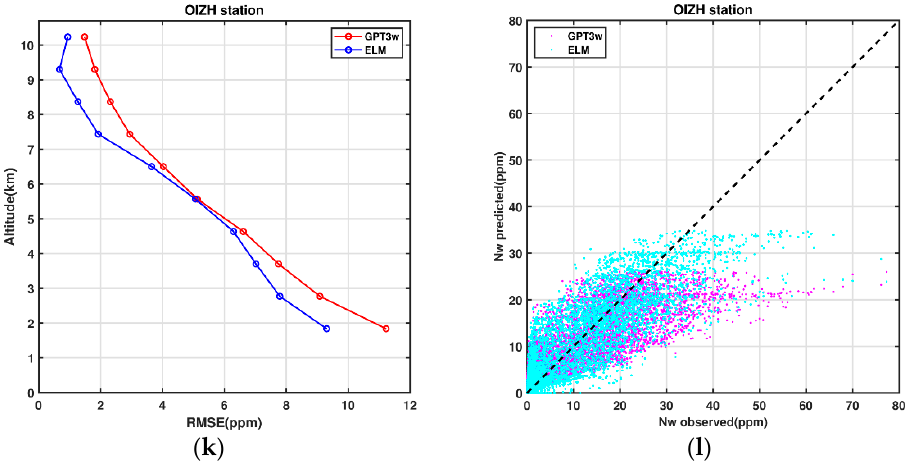
Figure 11. Comparison of the ELM- and GPT3w-derived wet refractivity indices with the corre- sponding radiosonde observations at six stations within Iran. The mean RMSE values for 10 differ- ent altitude levels are shown. Figures ( a , c , e , g , i , k ) represent the RMSE at different altitudes, and figures ( b , d , f , h , j , l ) represent the comparison of the ELM and GPT3w wet refractivity indices with the in-situ radiosonde observations.